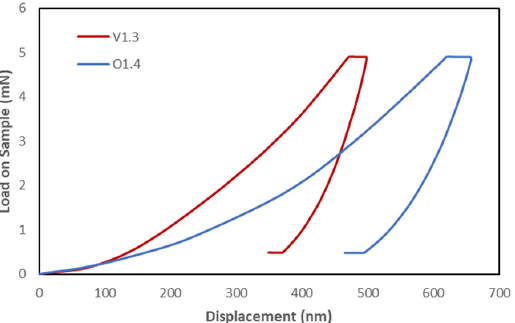
Figure 4. Representative load–displacement indentation curves of two bovine and ovine breastfed bone tissue samples. Table 3. Results of the nanoindentation tests for each evaluated sample. SFT refers to solid-food transitioning specimens.